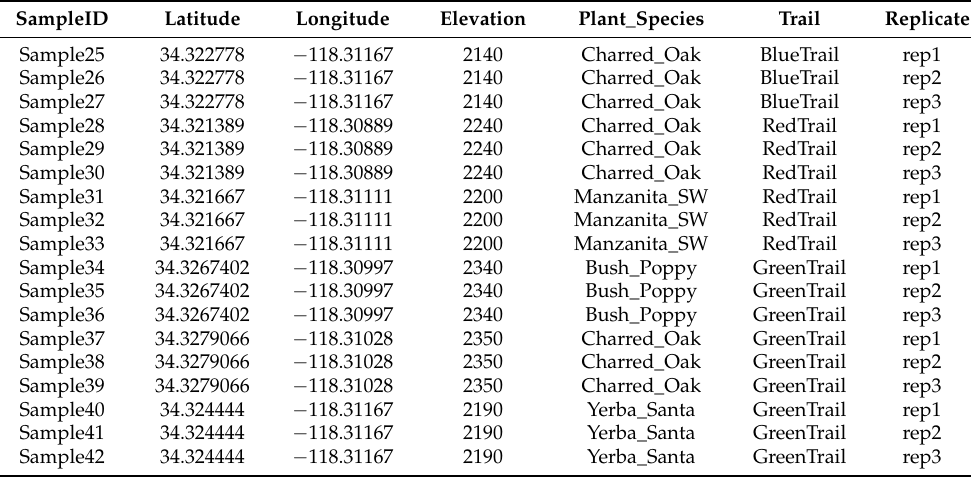
Figure 1. Left to Right: Round 1 soil sampling map (December 2020) and Round 2 soil sampling map (June 2021). Table 3. Sample metadata for Round 2